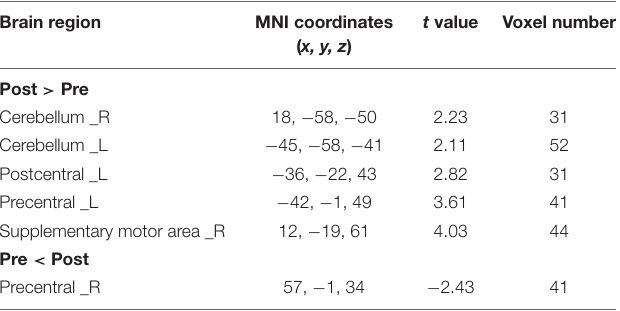
TABLE 4 | Brain regions showing significantly different FA between pre- and post-rTMS treatment. Brain region MNI coordinates ( x, y, z )